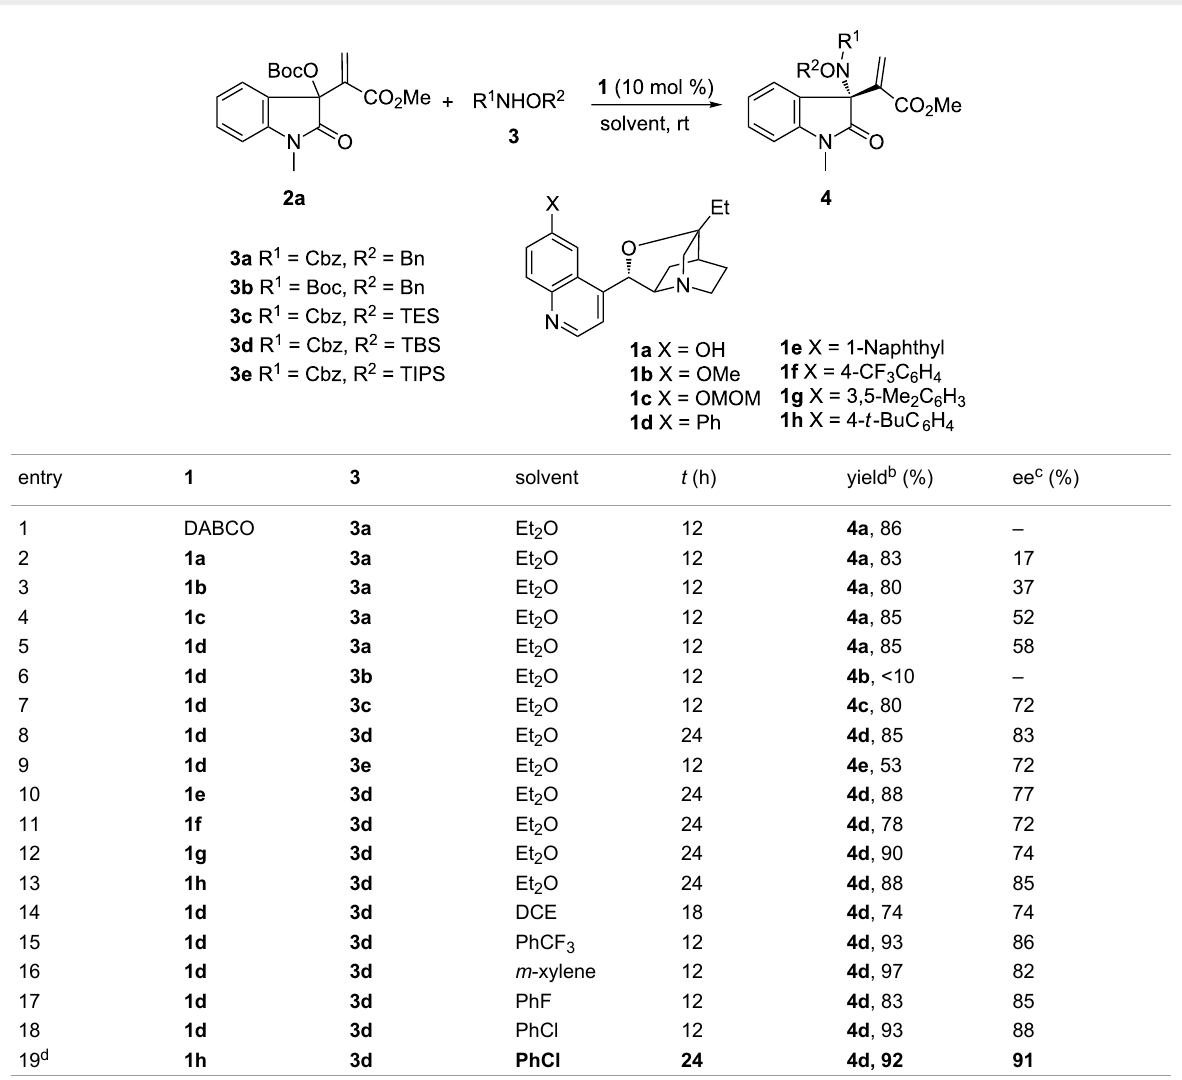
Table 1: Screening studies of asymmetric allylic amination of MBH carbonate of isatin.